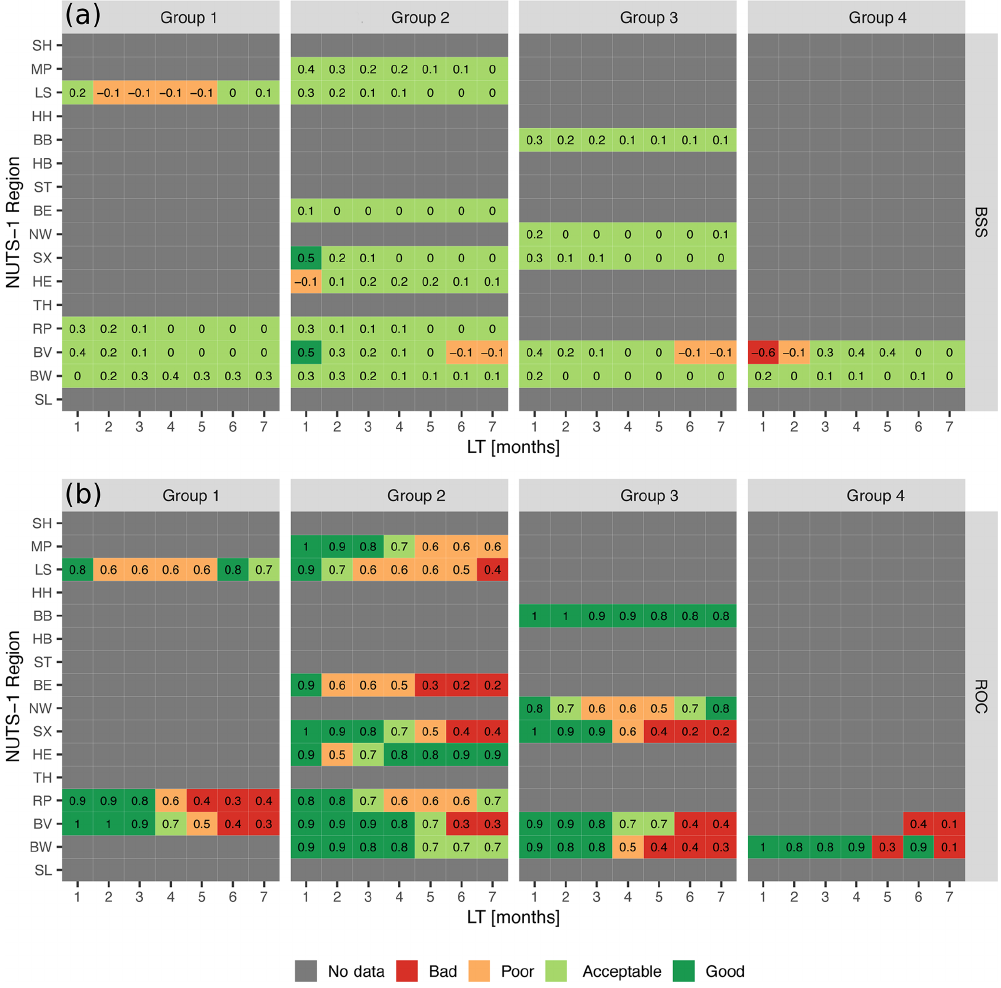
Figure 5. Skill of re-forecast drought impacts for four impact groups and each German NUTS-1 region using the random forest approach for the period 2002–2010. The performance is measured using (a) BSS and (b) ROC for lead times up to 7 months. For the acronym of NUTS-1 regions, see Fig.